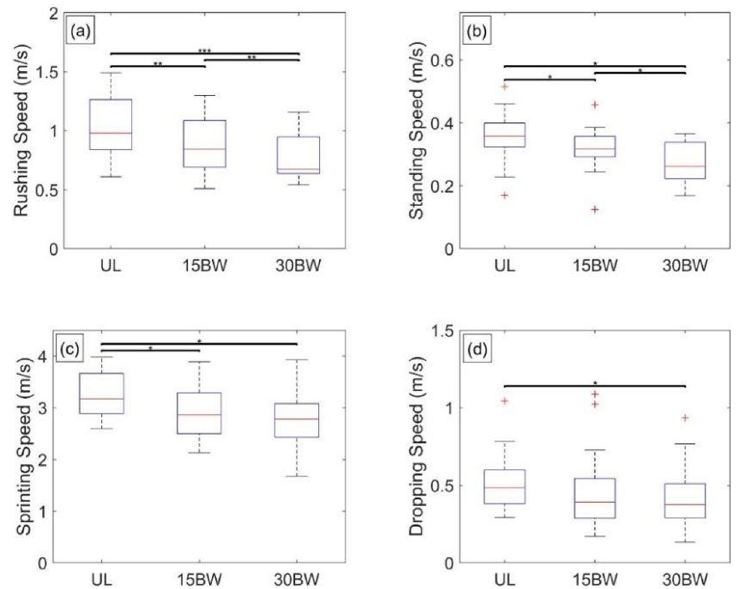
Fig 15. Bounding rush statistical results. Boxplots depicting the results from the Tukey post hoc analysis for a) rushing speed, b) standing speed, c) running speed, and d) dropping speed. The bars denote significant differences between loading conditions at a significance level α = 0.05 � , 0.01 �� , 0.001 ��� .